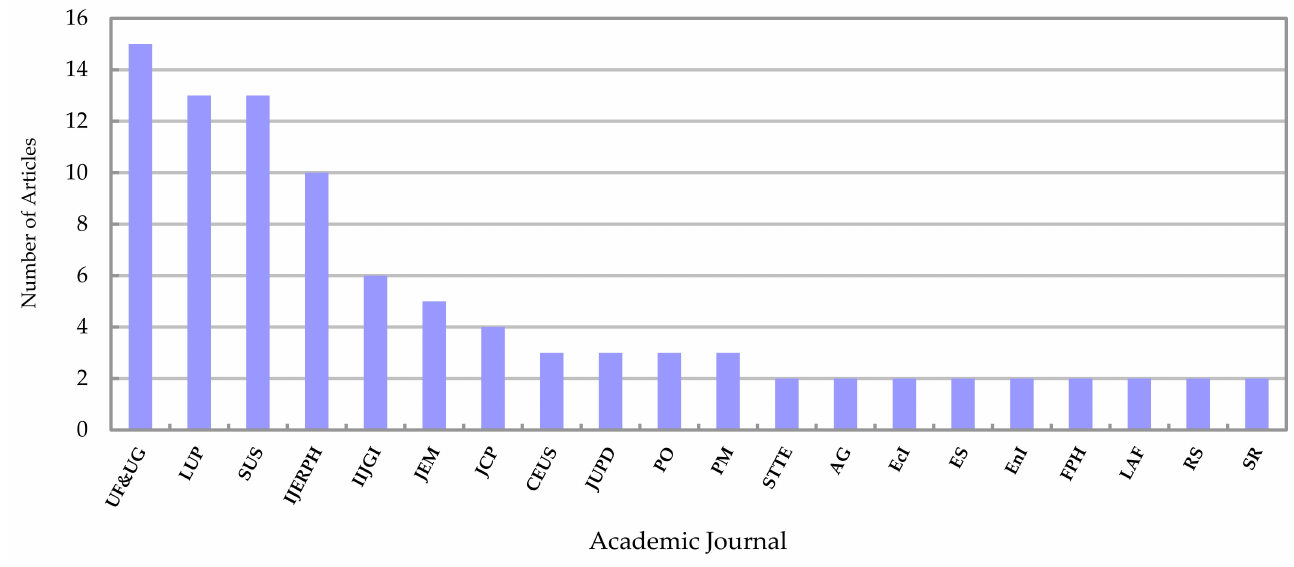
Figure 4. Distribution of papers in urban park research using big data indifferent journals. Note: UF&UG: Urban Forestry & Urban Greening; LUP: Landscape and Urban Planning; SUS: Sustainability; IJERPH: International Journal of Environmental Research and Public Health; IIJGI: Isprs International Journal of Geo-Information; JEM: Journal of Environmental Management; JCP: Journal of